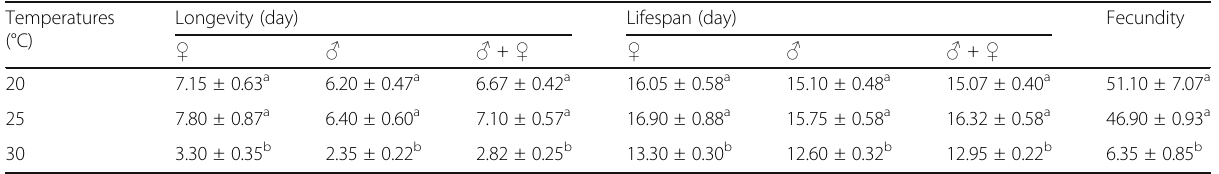
Table 2 Influence of various temperatures on adult longevity, lifespan, and fecundity of Aphidius matricariae parasitizing Schizaphis graminum Temperatures